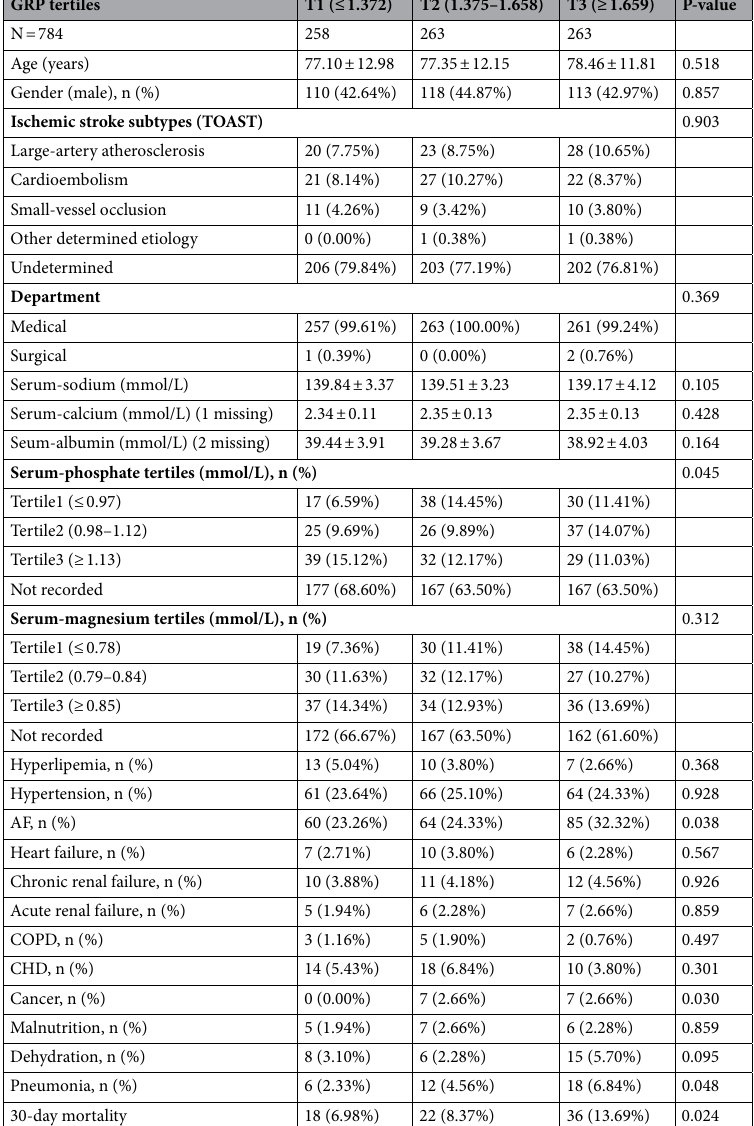
Table 1. Baseline characteristics of subjects according to tertiles of GPR level. All data in GPR subgroups were expressed as mean ± SD or number (%). GPR tertiles: Tertile 1: ≤ 1.372; Tertile 2: 1.375–1.658; Tertile 3: ≥ 1.659. serum glucose to potassium ratio, AF atrial fibrillation/atrial flutter, COPD chronic obstructive pulmonary disease, CHD coronary heart